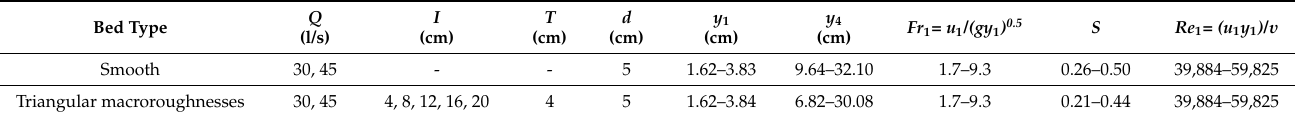
Table 2. Effective parameters in the numerical model.